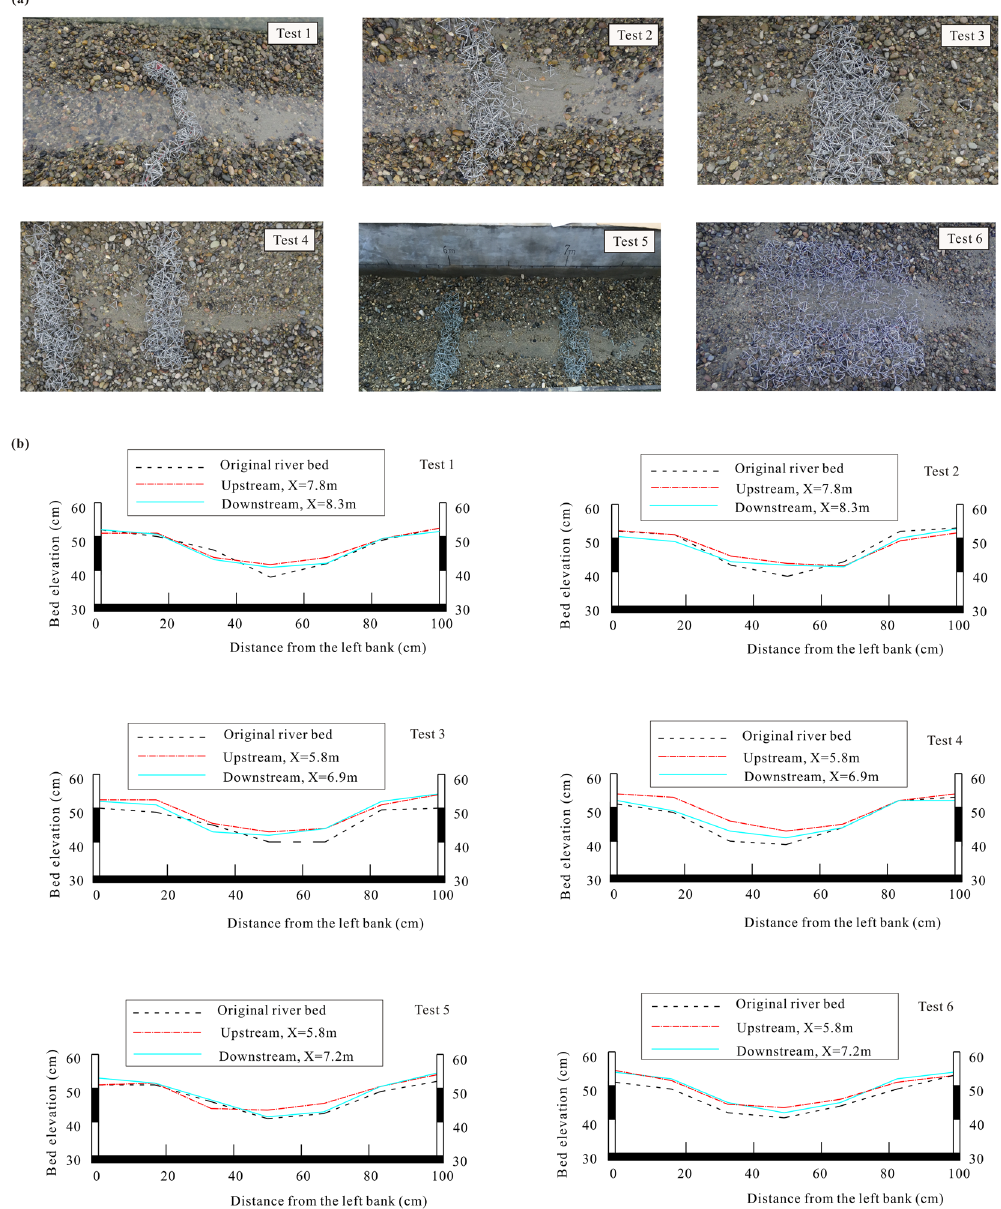
Figure 4. Deposition phenomena: ( a ) photos of the final morphology of a river bed protected by different TFPW and ( b ) variation in typical cross-sectional